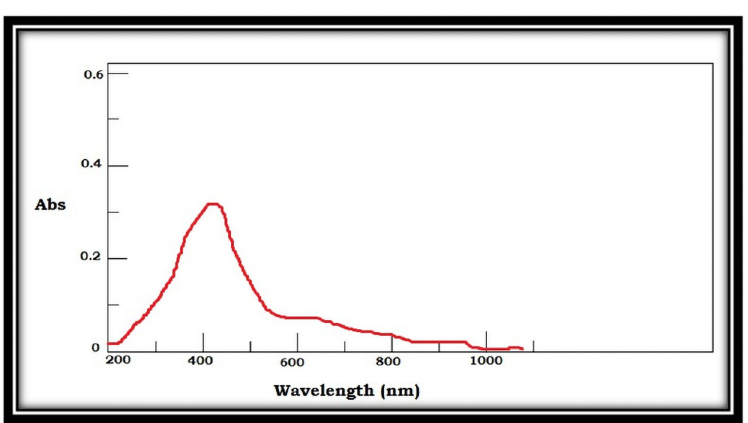
Fig 5. UV-VIS spectrum showing maximum absorption between 420-430nm.